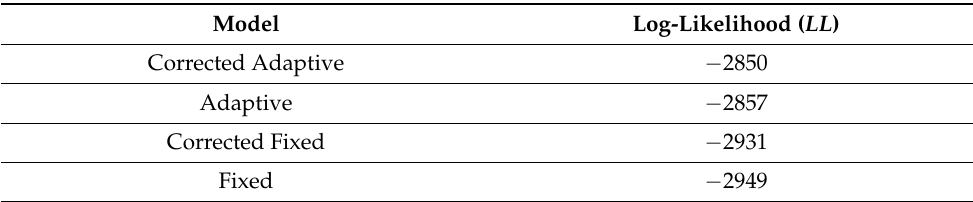
Table 4. Log-likelihood ( LL ) values for the smoothed seismicity models for testing catalog